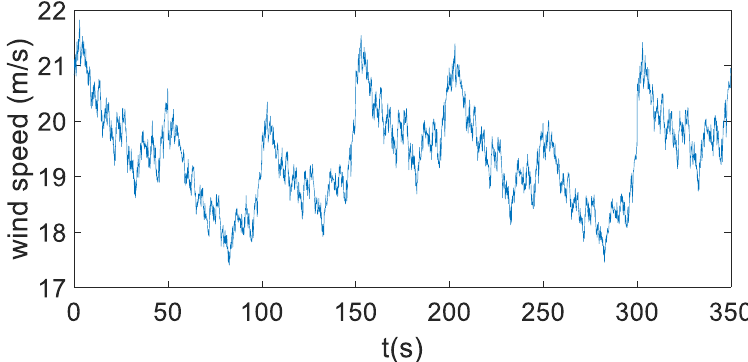
Figure 9. The wind speed in high wind speed region with slight turbulence.